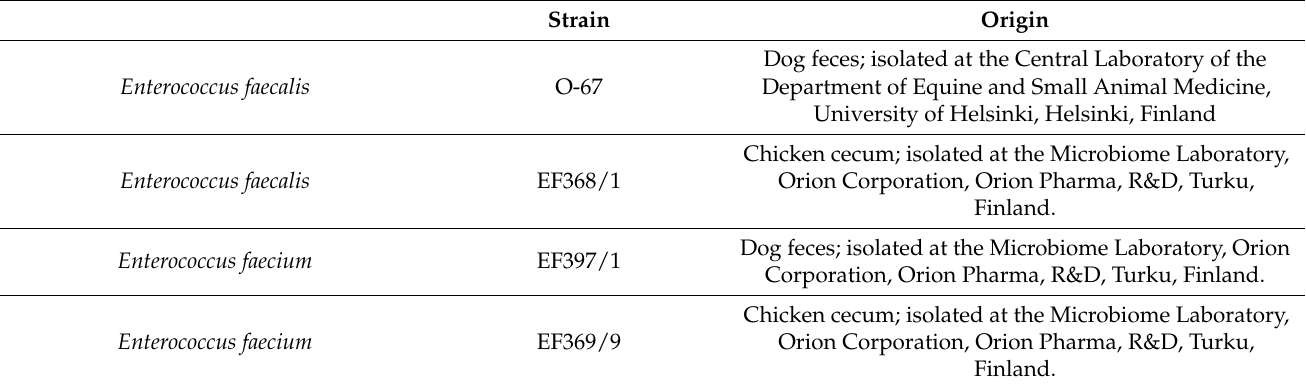
Table 1. List of bacterial strains used in this